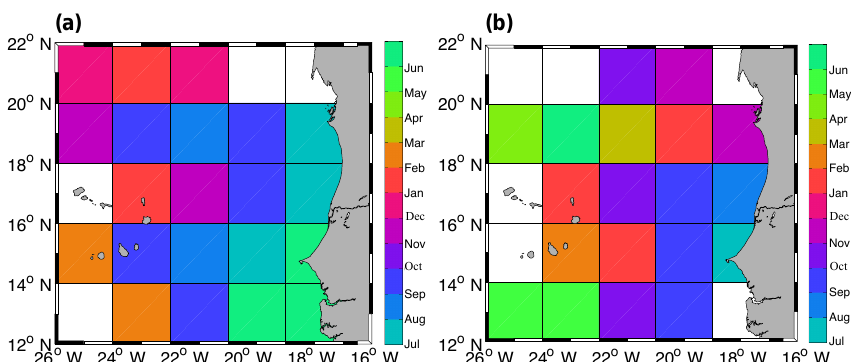
Figure 10. Phase of the annual harmonic of the number of detected eddies in 2 ◦ × 2 ◦ boxes based on the results of the OW method for (a) cyclones and (b) anticyclones. Phases are only shown for boxes with an amplitude larger than 2.5 eddies. Phase is given in month of the year with maximum eddy number.